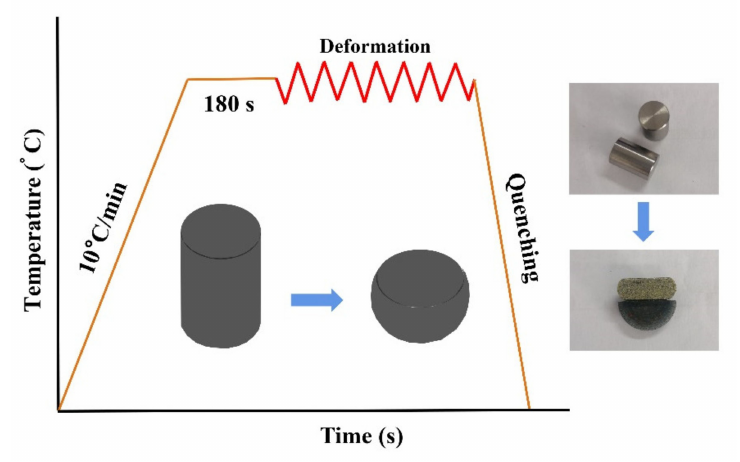
Figure 2. The diagram of the thermal simulation compression experiment process.